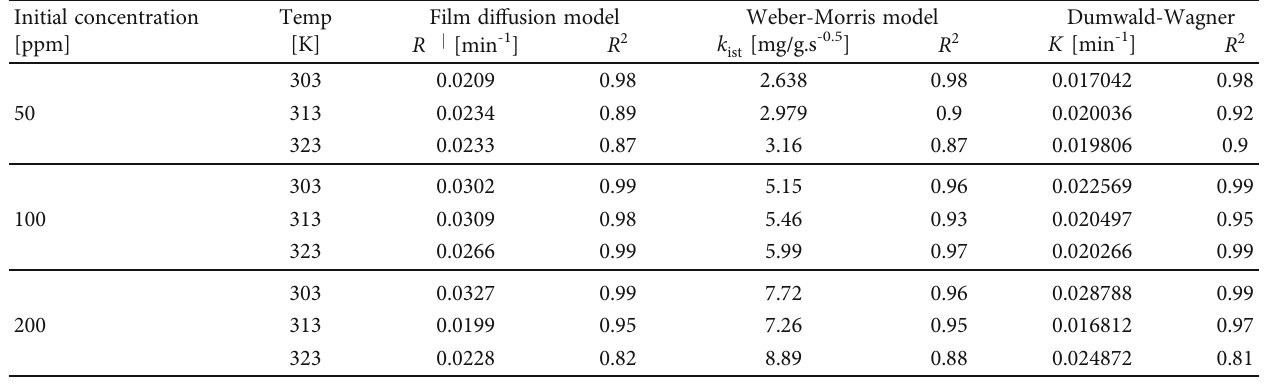
Table 9: Di ff usion model parameters.